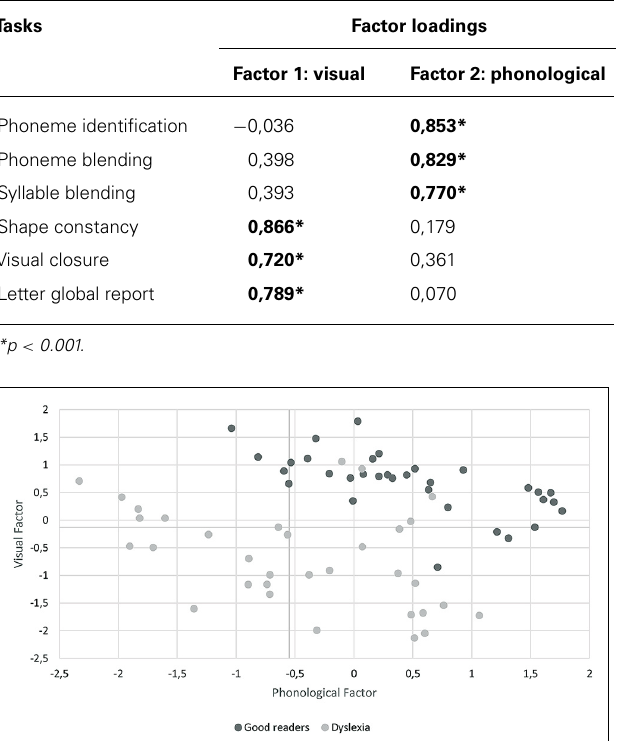
FIGURE 1 | Scatterplot’s graphic of the distribution of children with developmental dyslexia and control group based on their phonological and visual